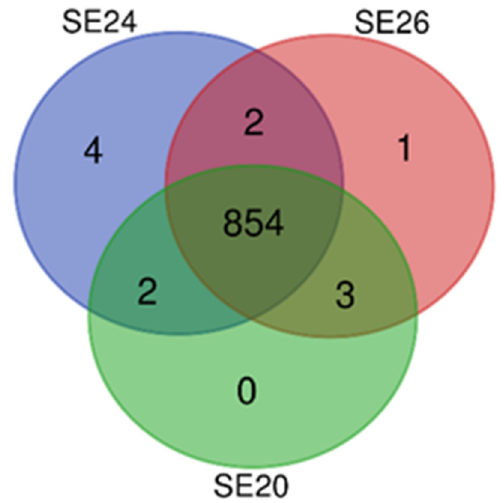
Figure 3. Venn diagram based on the consensus clusters of homologous proteins identified by the algorithms COGT and OrthoMCL. The predicted numbers of shared and unique protein-encoding genes derived from the three whole-genome-sequenced strains of Ca. N. mikurensis are shown.